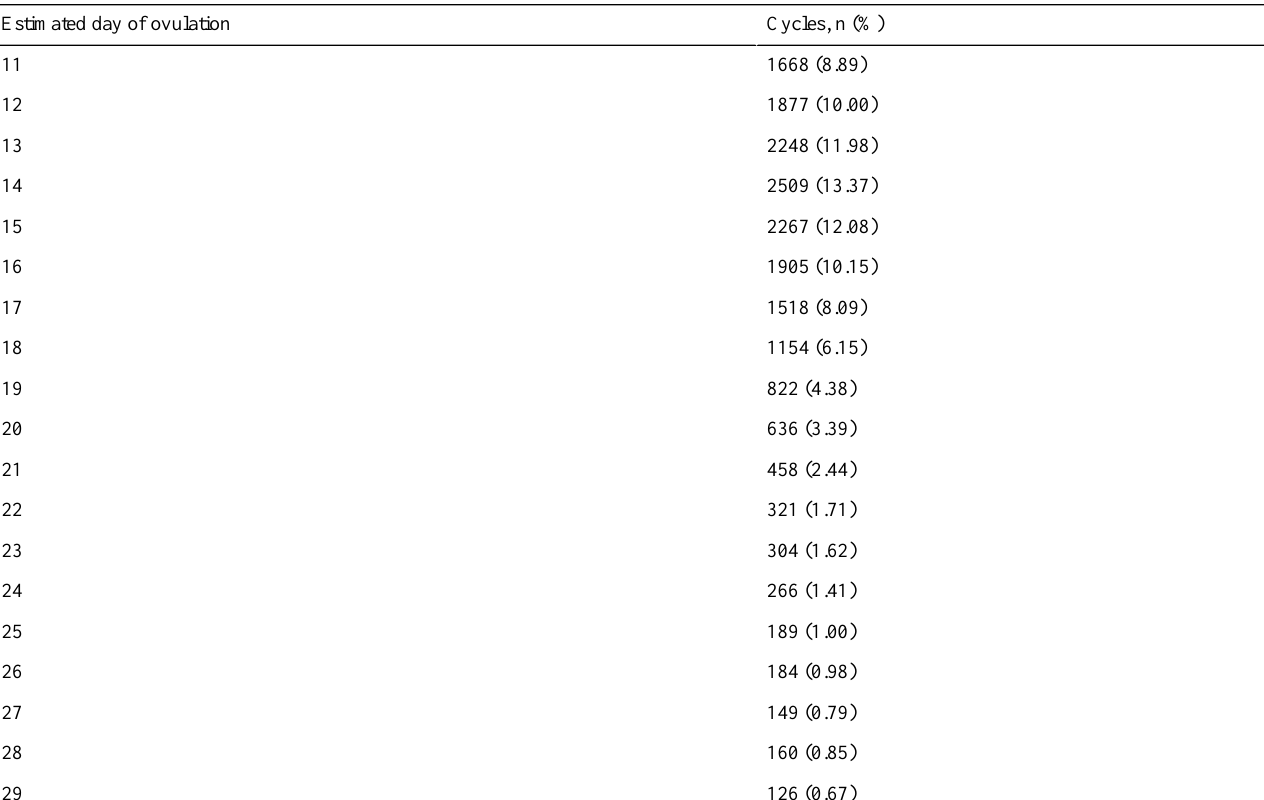
Table 3. Estimated ovulation day based on positive luteinizing hormone test (N=18,761 cycles).